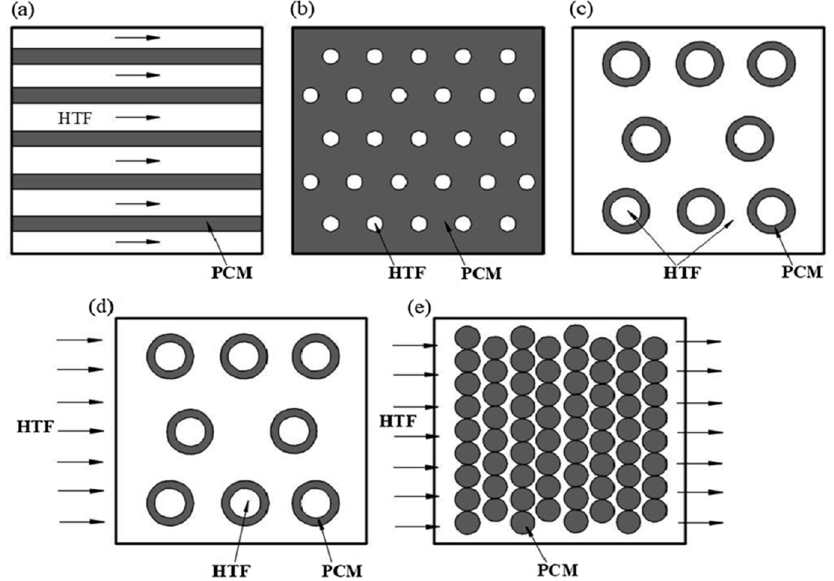
Figure 1. Different types of LHTES devices. ( a ) Flat plate; ( b ) Shell and tube—internal flow; ( c ) Shell and tube—parallel flow; ( d ) Shell and tube—cross flow; ( e ) packed bed. (Permission to reproduce from Ref. [2]).